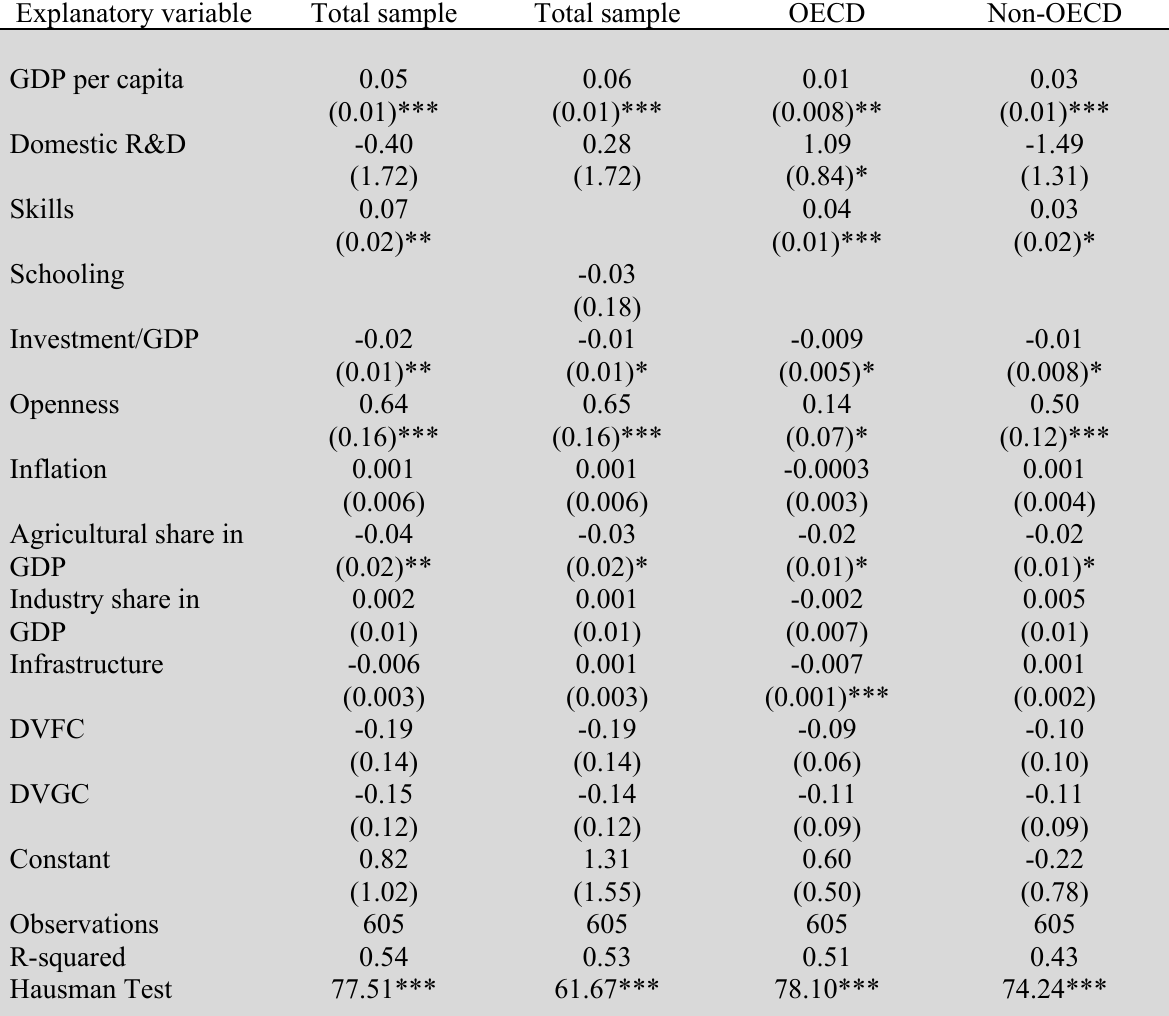
The determinants of technology transfer in Vietnam (Fixed effects panel data estimate) Dependent variable: The ratio of capital goods imports to